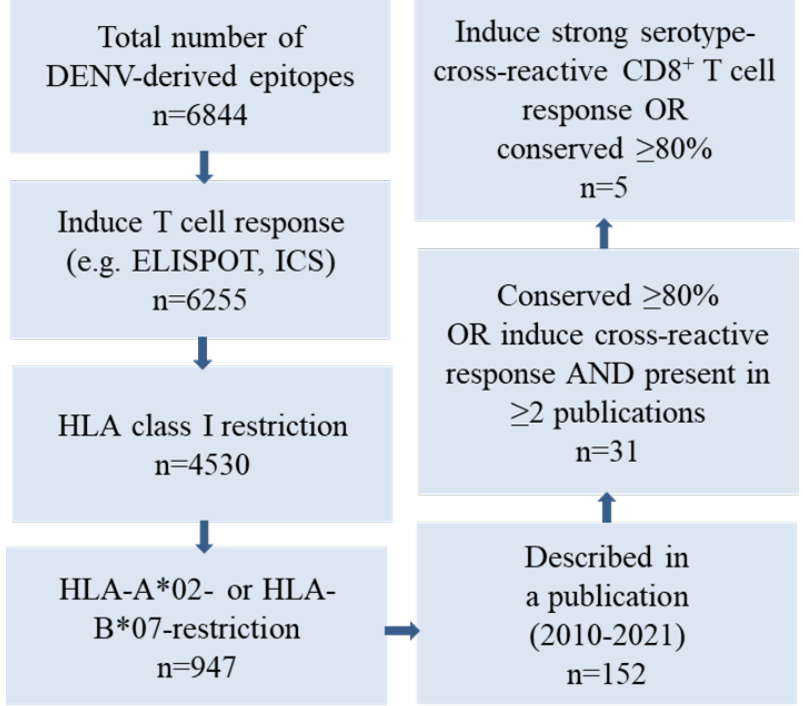
Figure 1. Selection of DENV-derived epitopes based on a query of the Immune Epitope Database (IEDB) of the NIAID. Five DENV-derived HLA-A*02- or HL-B*07-restricted epitopes were selected according to the magnitude of cross-reactive functional CD8 + T cell responses reported and/or conservation among the various DENV serotypes.